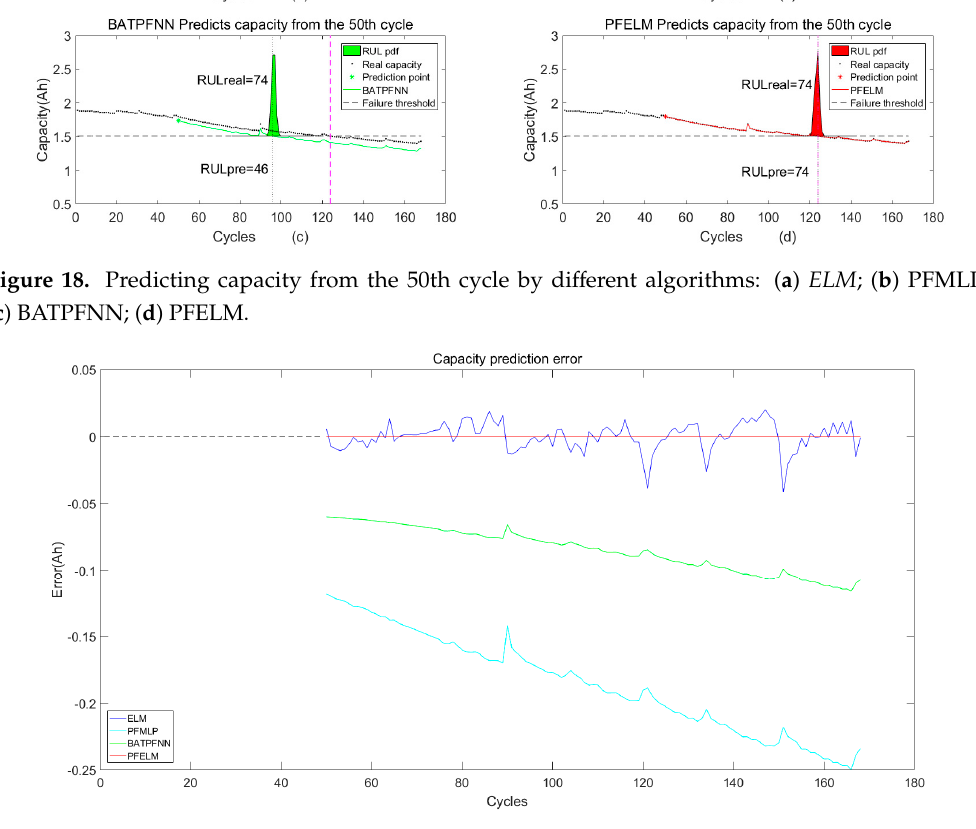
Figure 19. Capacity prediction error from the 50th cycle.